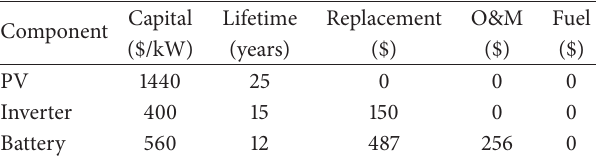
Table 2: Economic assumption of PV system.